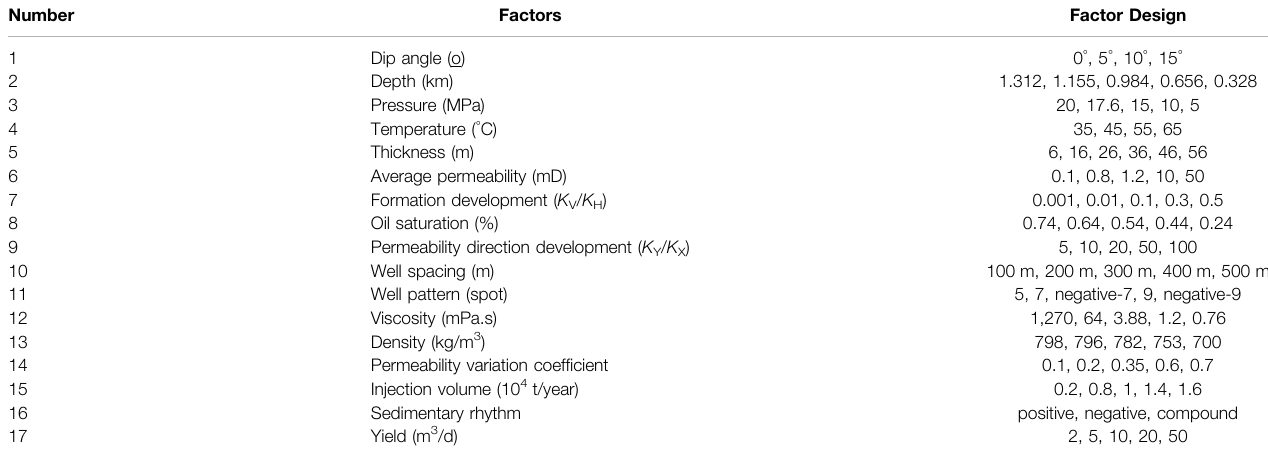
TABLE 2 | Model factor design. Number